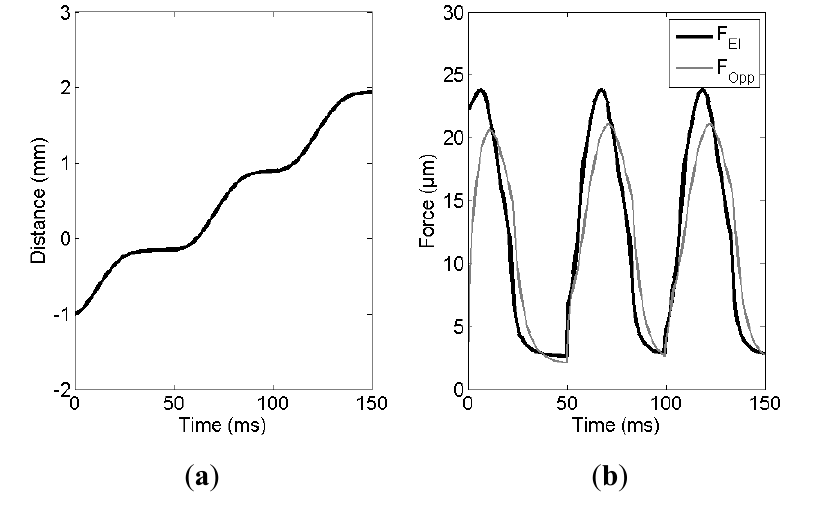
Figure 8. ( a ) Dynamic droplet response for the actuation over three subsequent electrodes for an actuation voltage of 40 V. ( b ) Evolution of the actuation and opposing force on the droplet as a function of